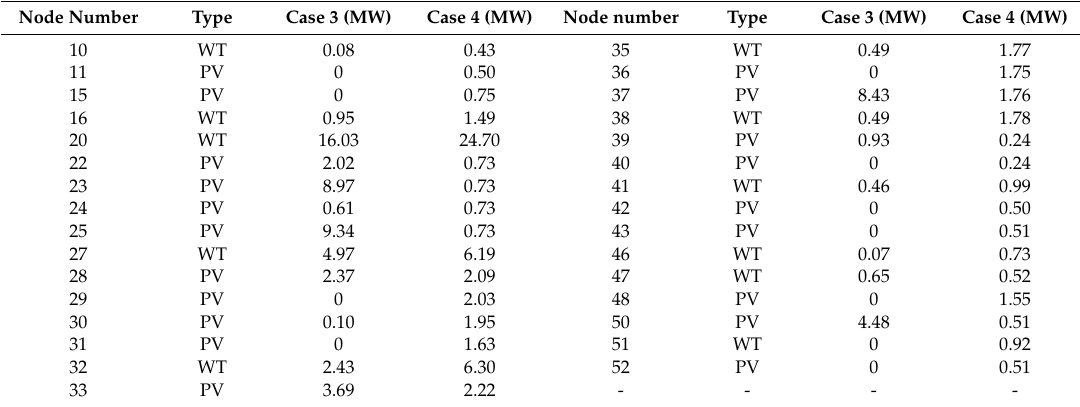
Table 3. Planning results for Case 3 and Case